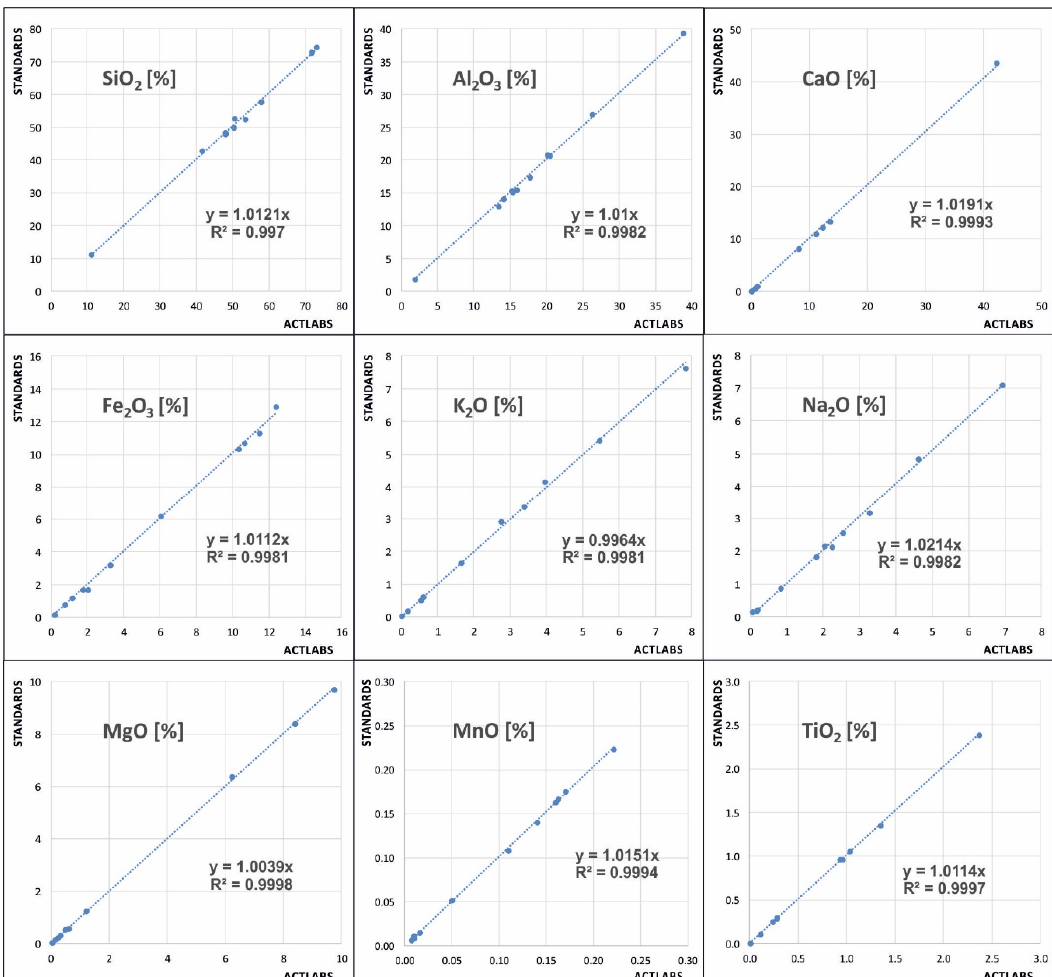
Figure 2. Correlation of chemical analysis results from ACTLABS laboratory (ICP-OES method) with certified values (the NIST standards).